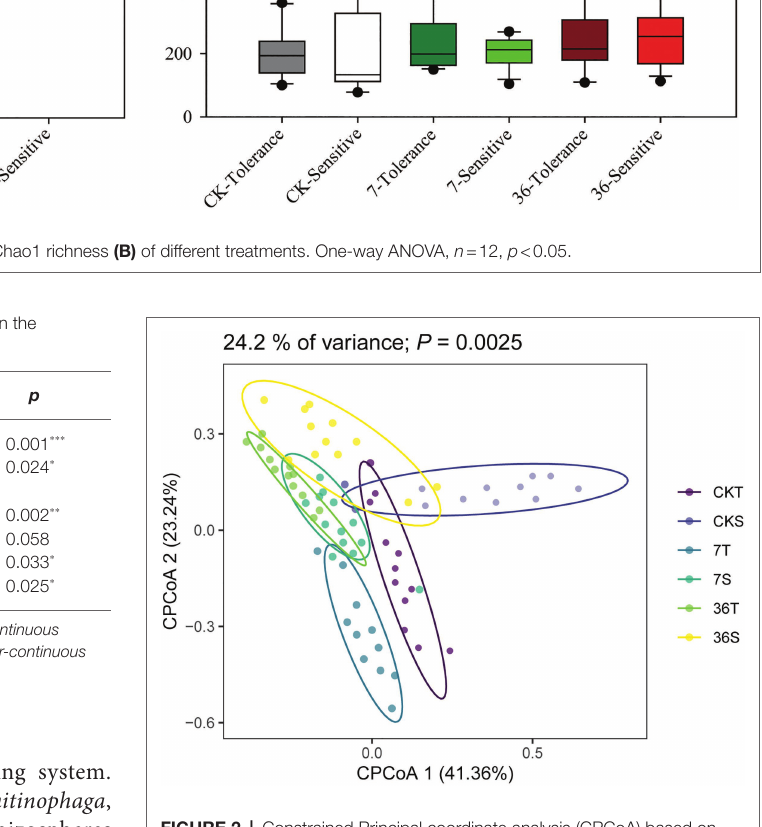
FIGURE 2 | Constrained Principal coordinate analysis (CPCoA) based on Bray-Curtis dissimilarities of 16S rRNA diversity in the